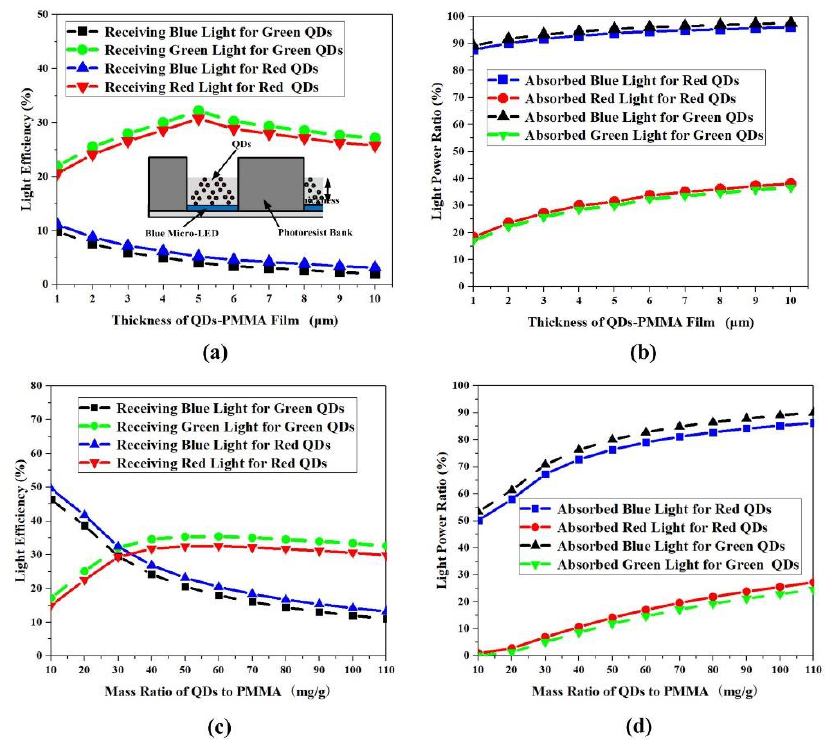
Figure 6. ( a ) Light efficiency distribution with different thickness; ( b ) light power ratio distribution with different thicknesses; ( c ) light efficiency distribution with different M R ; and ( d ) light power ratio distribution for with different M R .